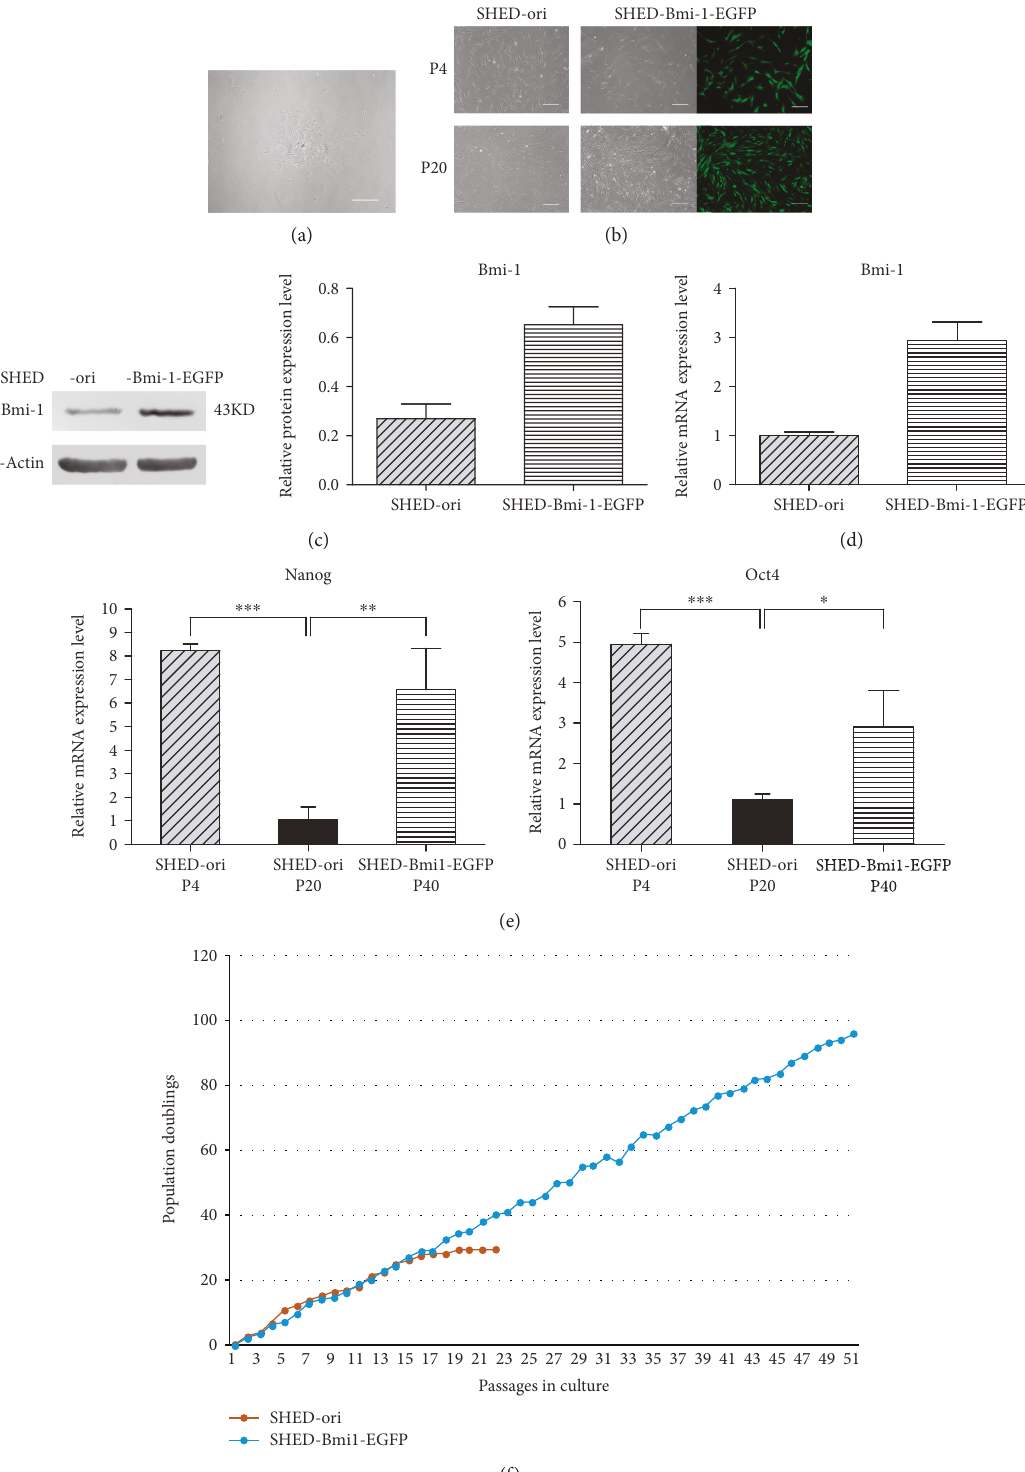
Figure 1: Establishment and veri fi cation of the immortalized cell line SHED-Bmi1-EGFP from primary SHED. (a) Representative image of colonies formed after 3d of isolation. Scale bar, 200 μ m. (b) Representative images of nontransfected original cells (SHED-ori) and SHED-Bmi1-EGFP with di ff erent passages. Scale bar, 200 μ m. (c) Protein level of Bmi-1 in SHED-ori P4 and SHED-Bmi1-EGFP P40 was detected by Western blot. The relative protein expression levels were normalized to β -actin. (d) Expression levels of Bmi-1 were assayed with qRT-PCR. (e) Expression levels of Nanog and Oct4 were assayed with qRT-PCR. (f) Population doublings (PDLs) of SHED-ori and SHED-Bmi1-EGFP. Data are shown as the mean ± SDs of 3 separate experiments. ∗ P < 0 05 , ∗∗ P < 0 01 , and ∗∗∗ P < 0